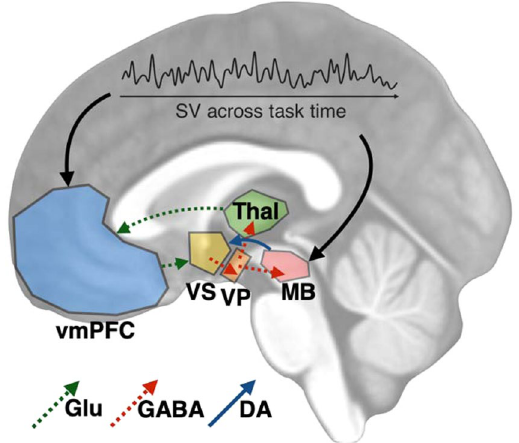
Figure 4. Illustration of a potential mechanism by which mesolimbic D2Rs impact subjective value (SV) and vice-versa. Binding of DA to D2Rs in the ventral striatum (VS) increases GABAergic signaling to the ventral pallidum (VP), which sends GABAergic projections to the thalamus (Thal) and midbrain (MB). GABAergic VP-MB signaling promotes DA release to the VS, while VP-Thal signaling promotes glutamate signaling in the ventromedial prefrontal cortex (vmPFC). The glutamatergic afferents from the vmPFC project to and promote local DA release in the